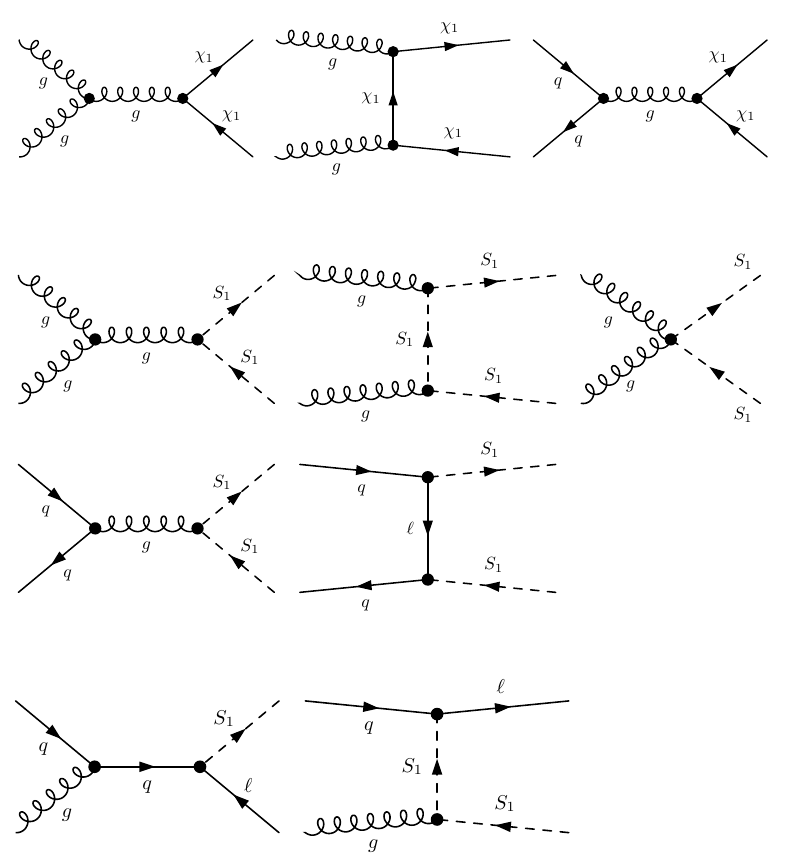
Figure 2 . Representative Feynman diagrams for the hadron collider processes pp → χ row), pp → S 1 S 1 (second and third rows) and pp → S 1 τ ± (bottom